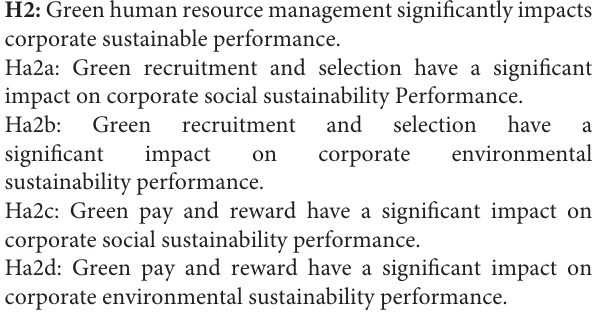
Frontiers in Psychology |